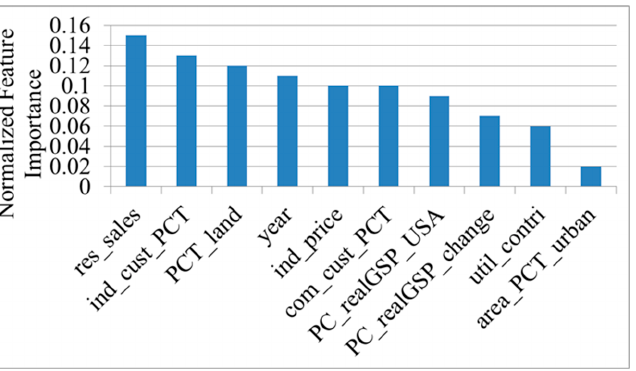
Figure 16. Feature importance ranking for revenue loss with observed outage duration in top 10 affected states. 10 affected